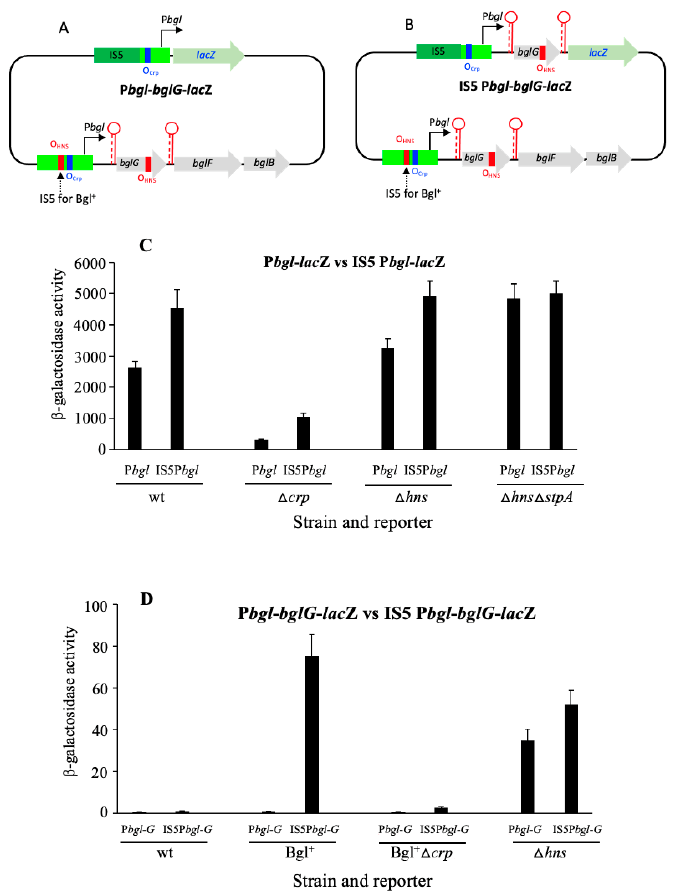
Figure 4. IS5 insertion stimulates both promoter and operon activities. ( A ) Diagram showing IS5 insertion at the P bgl reporter (IS5P bgl ‐ lacZ ). An IS5 element in the reverse direction is located at -207.5 upstream of the bglG translation start site. The native bgl operon is unchanged. ( B ) Diagram showing IS5 insertion at the bgl operon reporter (IS5P bgl ‐ bglG ‐ lacZ ). IS5 orientation and location are the same as in Figure 4A. In both ( A ) and ( B ), the blue bars represent the Crp binding sites (O Crp ) while the red bars represent the proposed H ‐ NS binding sites (O HNS ). ( C ) Effects of IS5 insertion on P bgl activities. ( D ) Effects of IS5 insertion on bgl operon activities. In both ( C ) and ( D ), test strains were cultured in M63 with glycerol and salicin as carbon sources. Sample collections and β‐ galactosidase assays were carried out as in Figure 1.